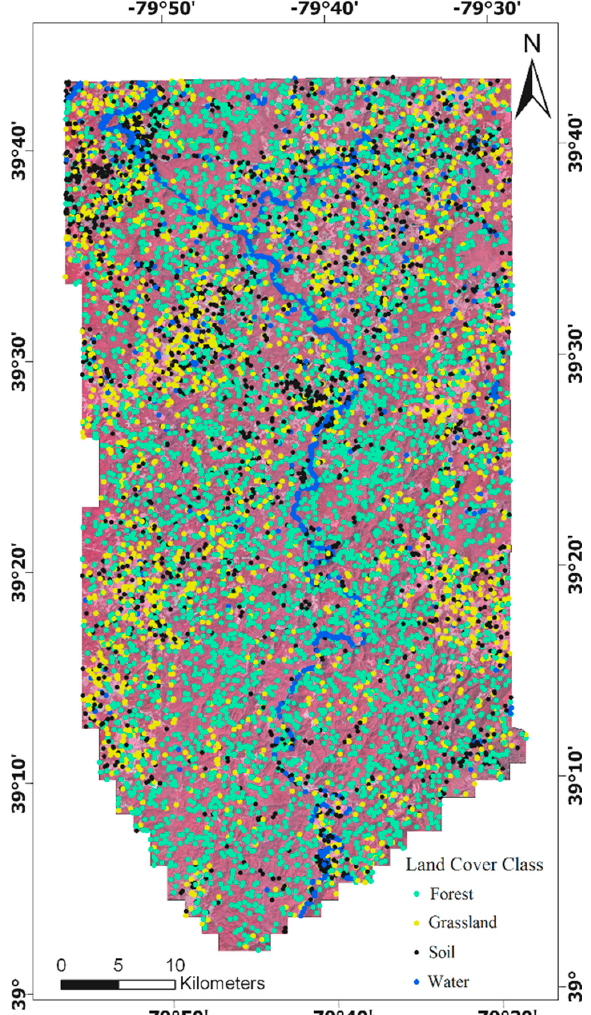
Figure 2. Location of training sample image-objects (n = 10,000). (Note: Each sample is indicated by a uniformed-size dot; the size and shape of the associated image-object is unrelated to the size and shape of the dot). Table 3. Training and validation data sample sizes and composition.